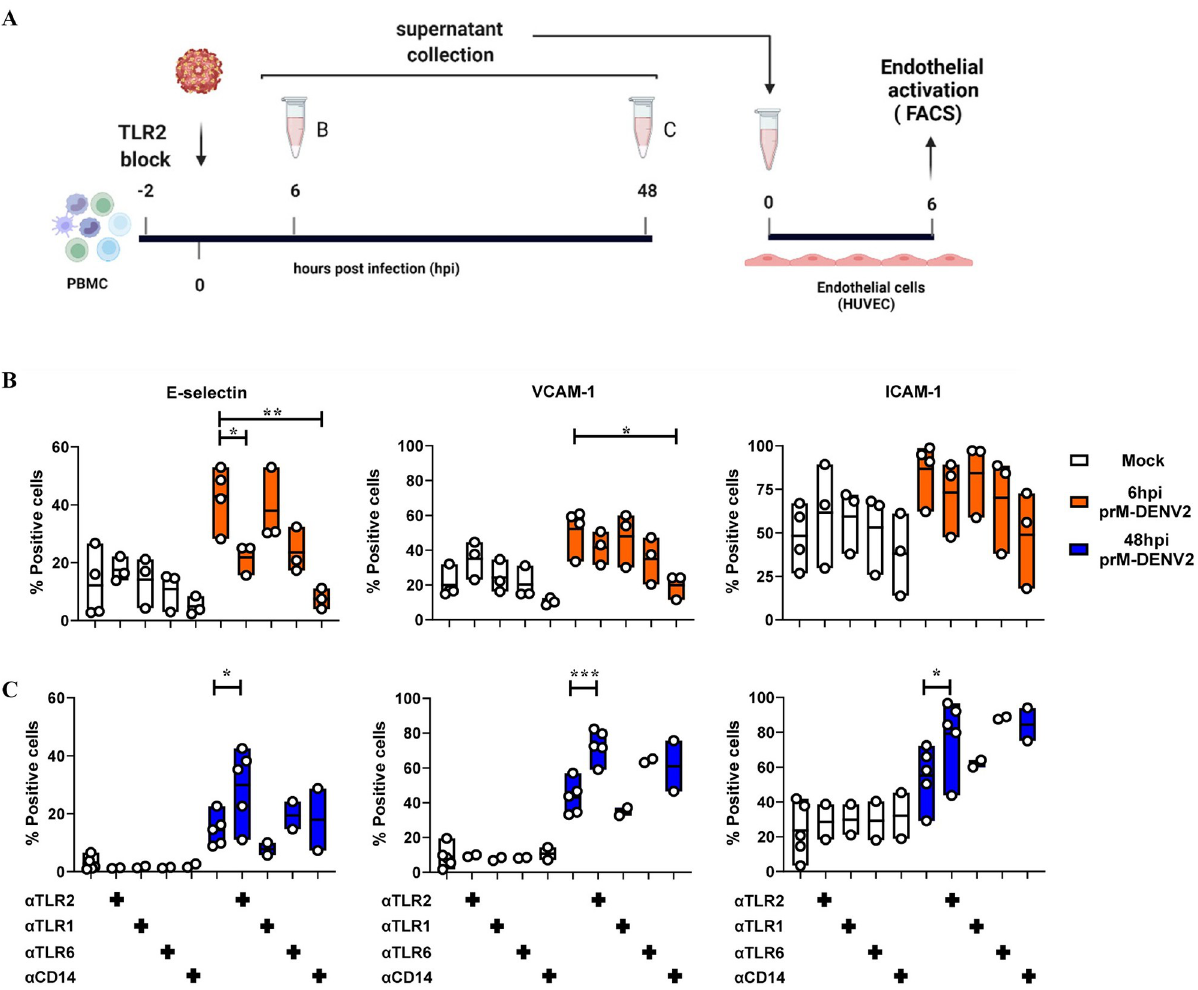
Fig 5. TLR2/TLR6/CD14 axis controls the early, but not the late onset of soluble inflammatory responses induced by prM-DENV2. ( A ) HUVEC were incubated for 6h with cell-free supernatants from PBMCs (n = 2–5, two to five different donors) (mock)-exposed for ( B ) 6h and ( C ) 48h to prM-DENV2 at a MOG of 300 in the presence or absence of TLR2/TLR1/TLR6/CD14 blocking antibodies. Surface expression of E-selectin, VCAM-1 and ICAM-1was determined by flow cytometry and represented as percentage of positive cells. P values were determined by unpaired one-tailed t-test. ( � P < 0.05, �� P < 0.01, ��� P < 0.001). ( A ) Figure created with